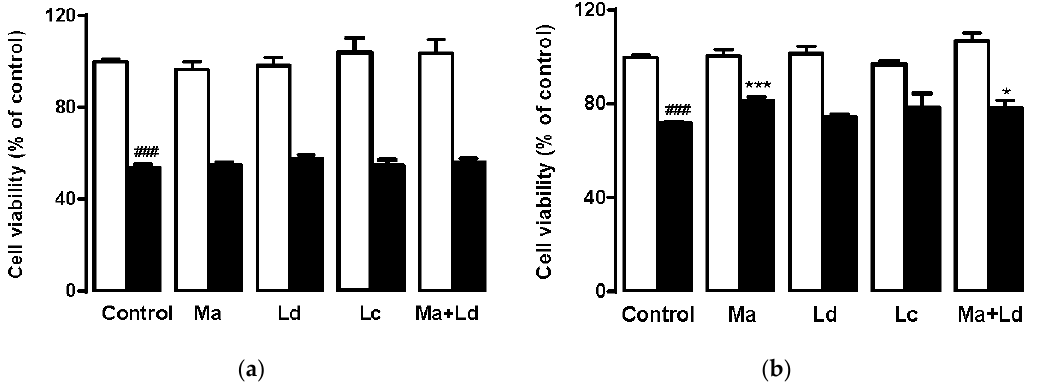
Figure 3. Effect of M. aquatica , L. dentata and L. cardiaca hydroethanolic extracts on HepG2 viability incubated with 500 μ M or 1.5 μ M K 2 Cr 2 O 7 for 6 h ( a ) or 72 h ( b ), respectively, in absence (white bars) or in presence (black bars) of K 2 Cr 2 O 7 . Values are expressed as means ± S.D. of percentage of cell viability with respect to control (untreated cells). Ma, M. aquatica extract; Ld, L. dentata extract; Lc, L. cardiaca extract.